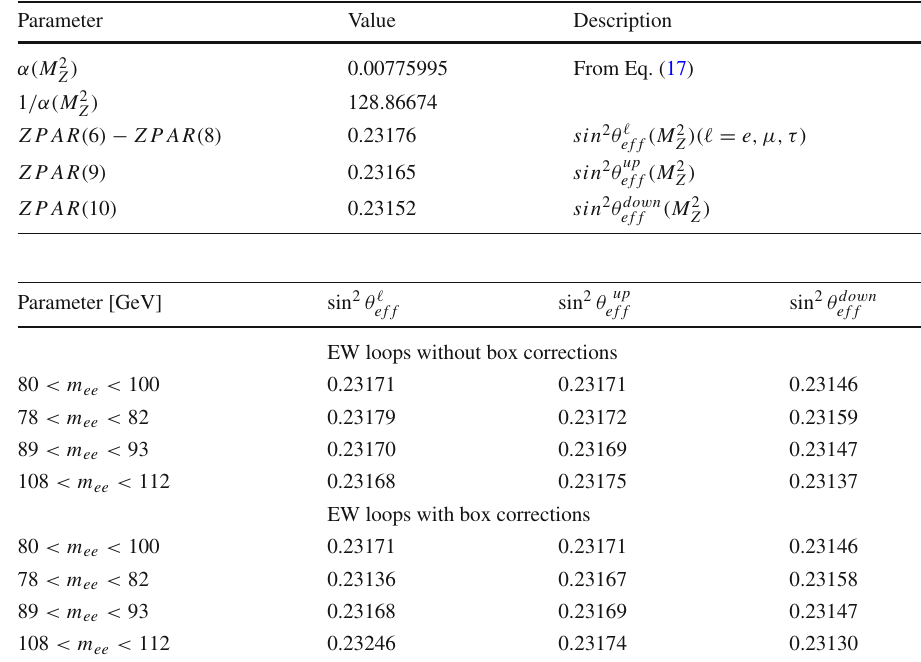
= 0 . 22352 were used. Only the real part W ( s , t ) is only about 10 − 4 f